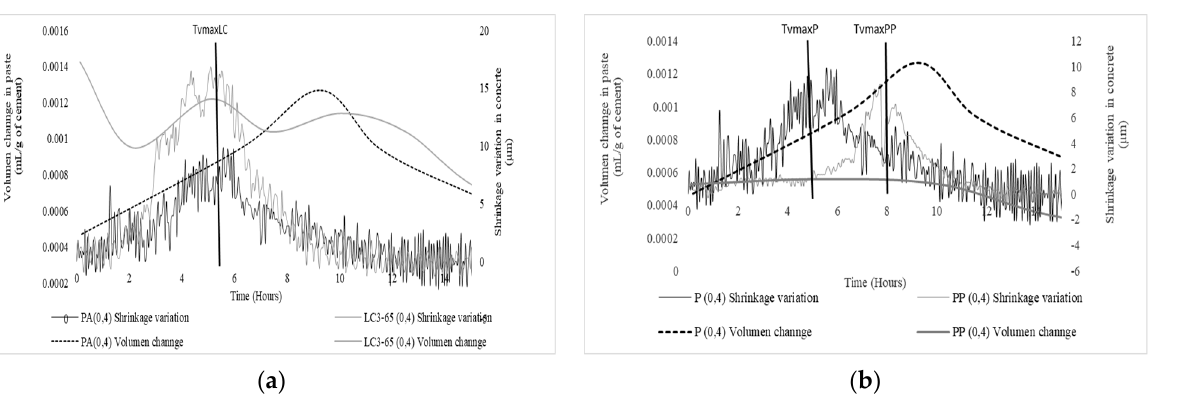
Figure 8. Relationship between shrinkage in concrete and hydration of cement: ( a ) combinations of OPC and LC2, and ( b ) pozzolanic cement containing 15% of natural pozzolan binder (PPC).